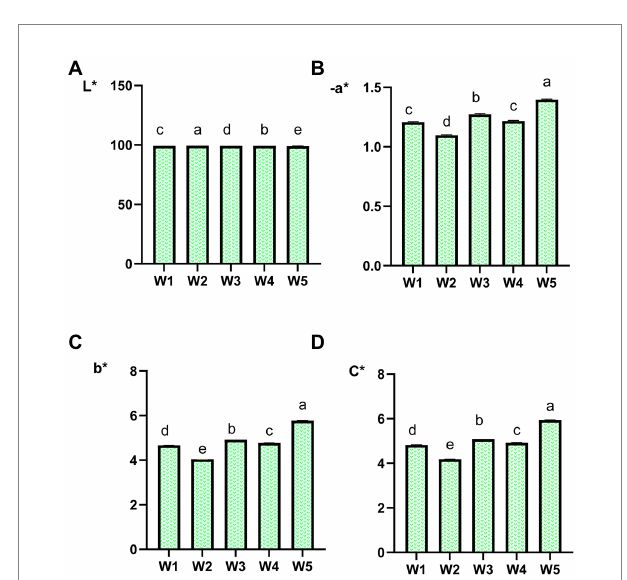
FIGURE 2 Distinction in color attributes L*, − a*, b*, and C* between Longjing tea infusions with different withering degrees. Different letters indicate a significant difference. And significant differences were obtained by one-way ANOVA with LSD post hoc test. p < 0.05 is considered as significant. A, L* (brightness). B, −a* (green). C, b* (yellow). D, C* (color